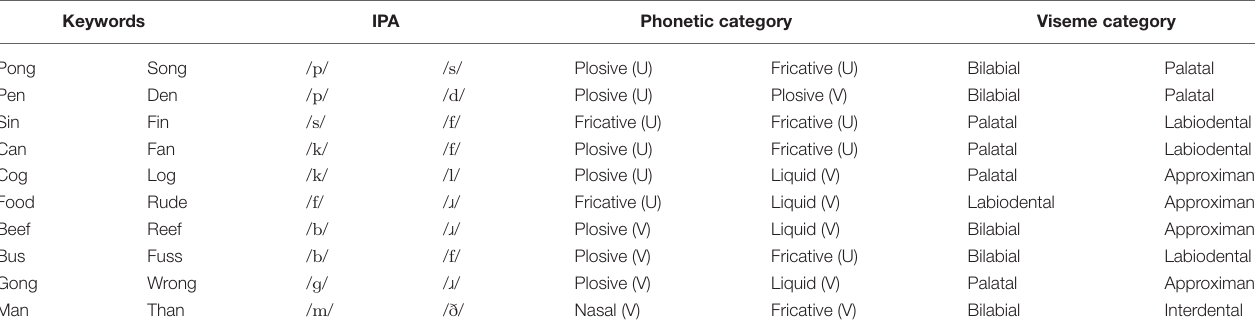
TABLE 2 | Word pairs used in the perceptual